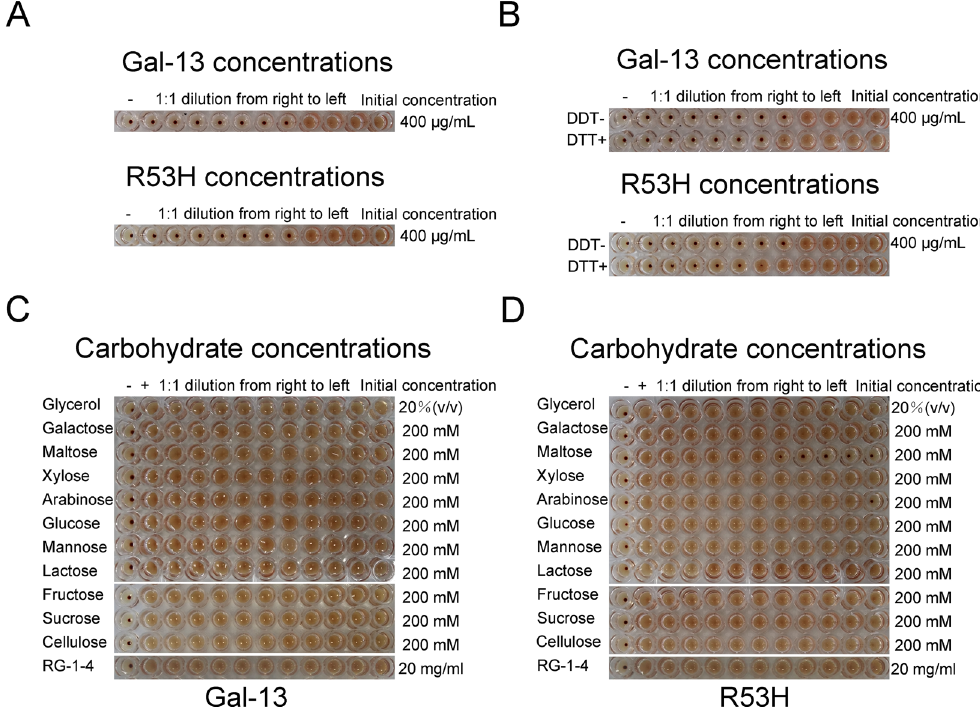
Figure 3. Hemagglutination Assay. ( A ) Gal-13 and R53H induce agglutination of chicken erythrocytes with an MAC (minimum agglutination concentration) value of 50 µ g/ml. Panel A in this figure shows two rows of 12 wells each, the top row for Gal-13 and the bottom row for R53H. In each row, the well at the far right contains the maximum concentration used, i.e., 400 μ l/ml. Moving then to the left in each row, serial dilutions were made as follows: 400, 200, 100, 50, 25, 12.5, 6.25, 3.13, 1.6, 0.8, and 0.4 μ l/ml. The final well at the far left contains no protein as a negative control. Whereas 50 µ g/ml Gal-13 or R53H induced agglutination, 25 µ g/ml did not. Therefore, the MAC (minimum agglutination concentration) value is 50 µ g/mL. ( B ) DTT did not significantly influence Gal-13-induced hemagglutination. ( C ) No carbohydrates tested could inhibit Gal-13-induced hemagglutination. ( D ) Aside from maltose and arabinose, all other carbohydrates could not inhibit R53H-induced